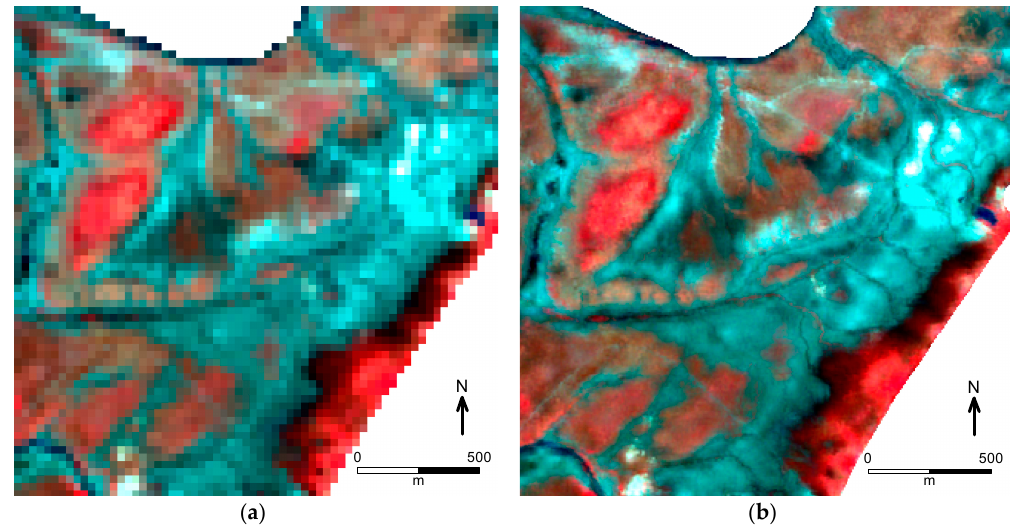
Figure 9. ( a ) Original Landsat image (5 October 2014, 5-4-3) and ( b ) images downscaled by cokriging (126.60°E, 35.73ºN).